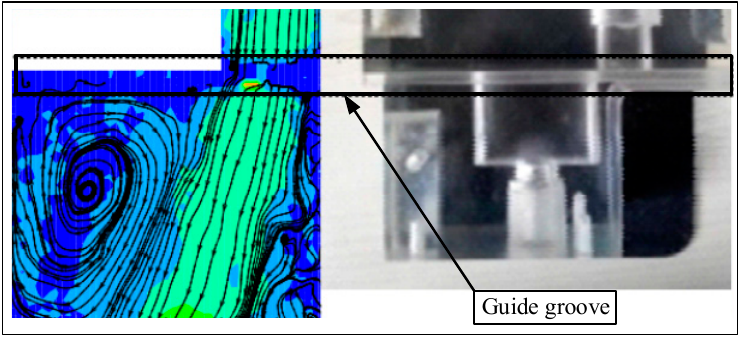
Figure 16. Guide groove.